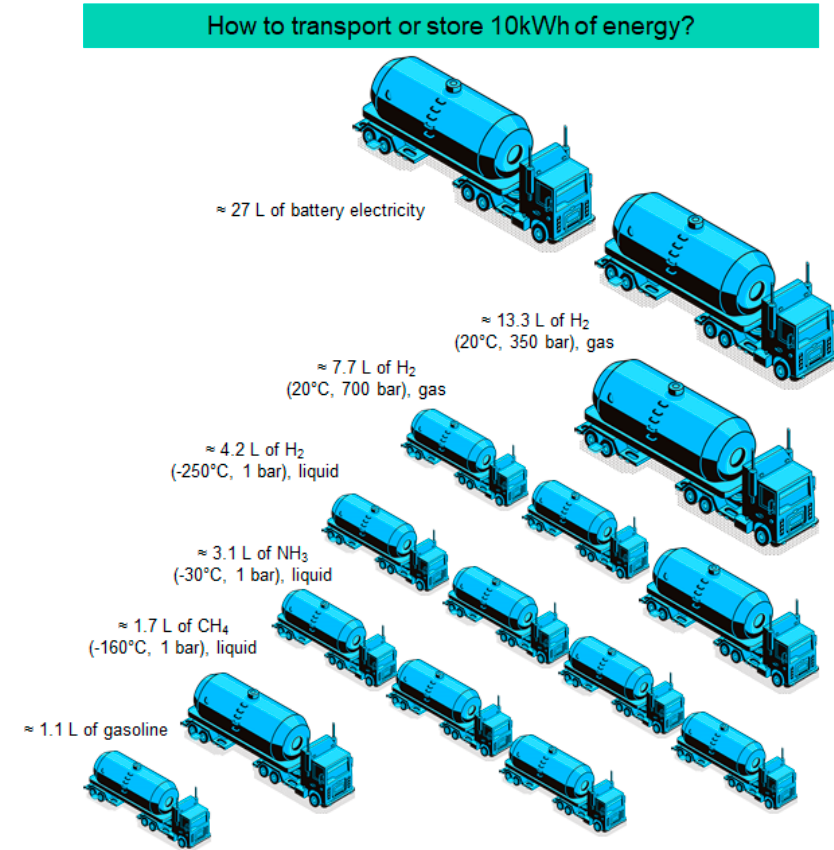
Figure 1. Transport or storage volume of 10 kWh of energy using different energy carriers.